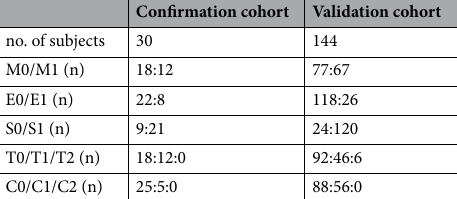
Table 4. Pathological characteristics of patients with